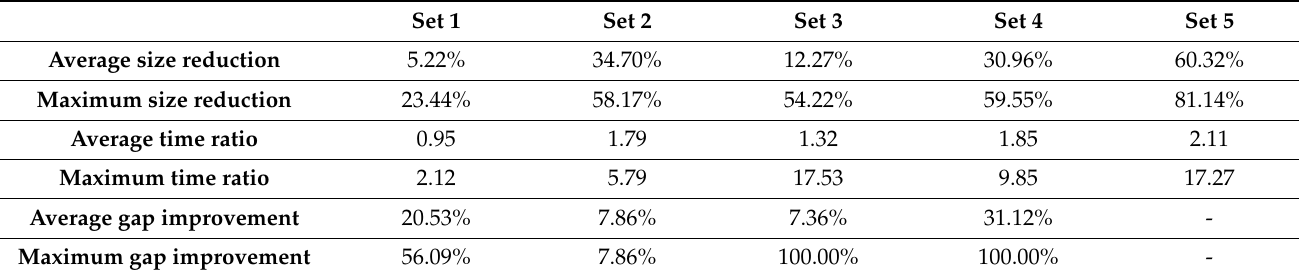
Table 5. Impact of graph compression.